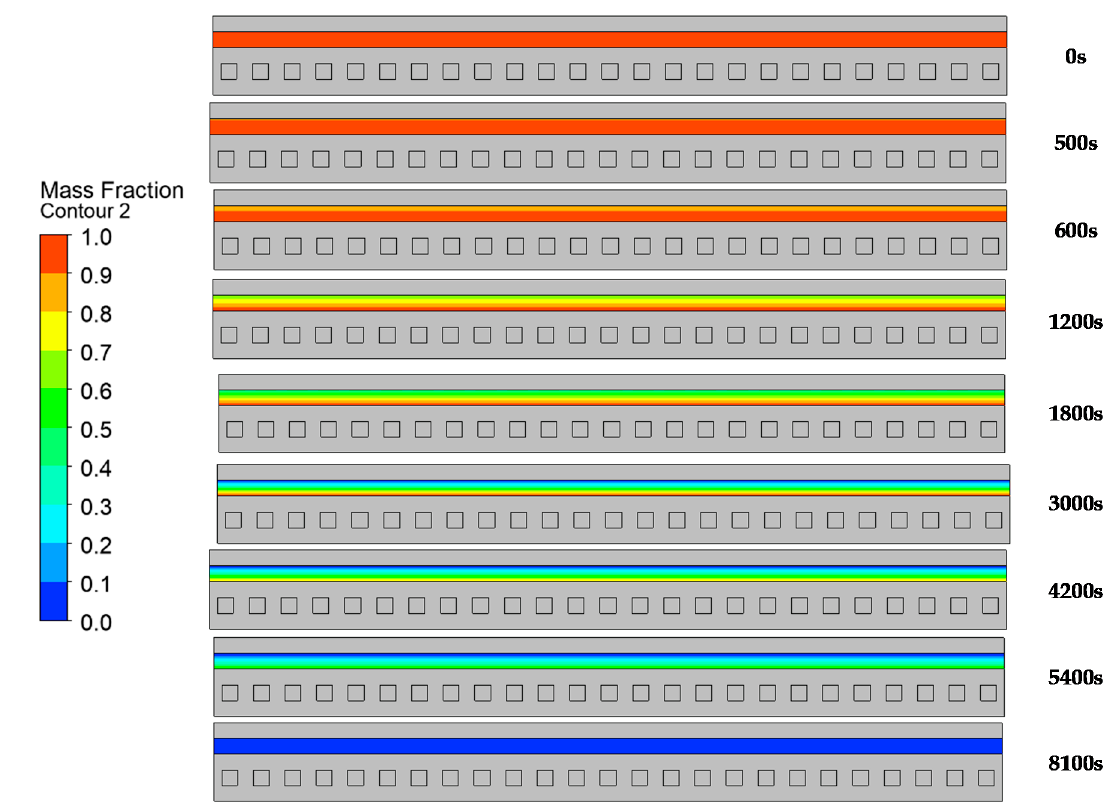
Figure 9. A section through the PCMHPHS during the cooling phase, displaying the PCM liquid fraction over time.